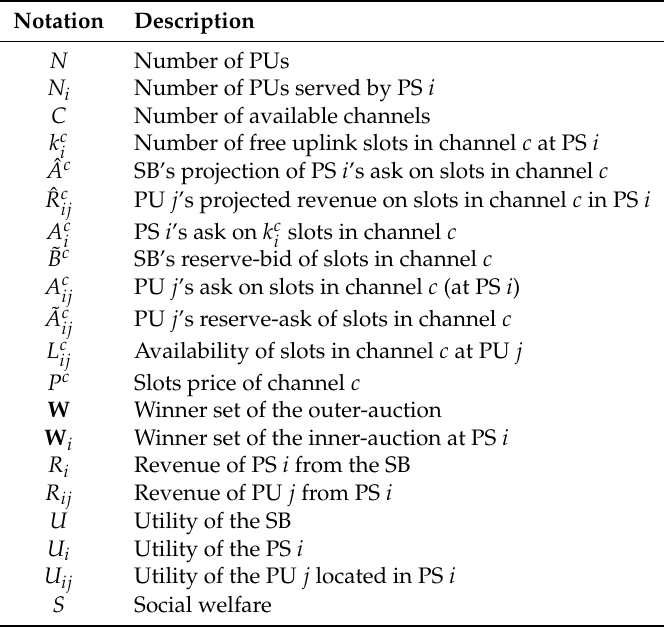
Table 2. Summary of